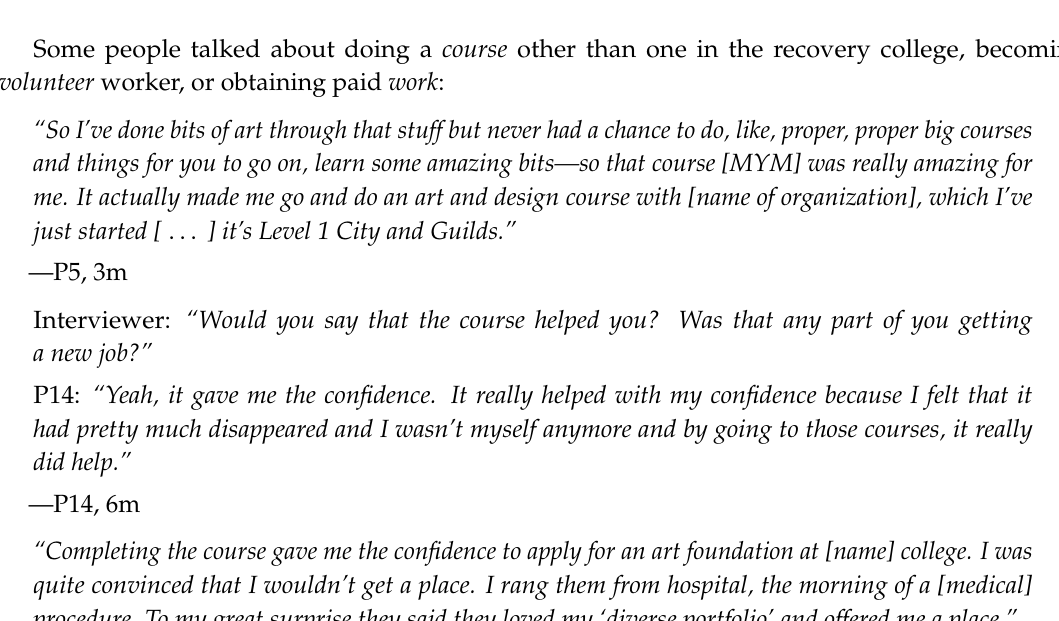
Table 9. Themes and sub-themes at each follow-up interview ( n = 24) n Participants at n at Six Months n at Nine Months Main Theme Sub-Themes Three Months Maintaining wellbeing Using skills